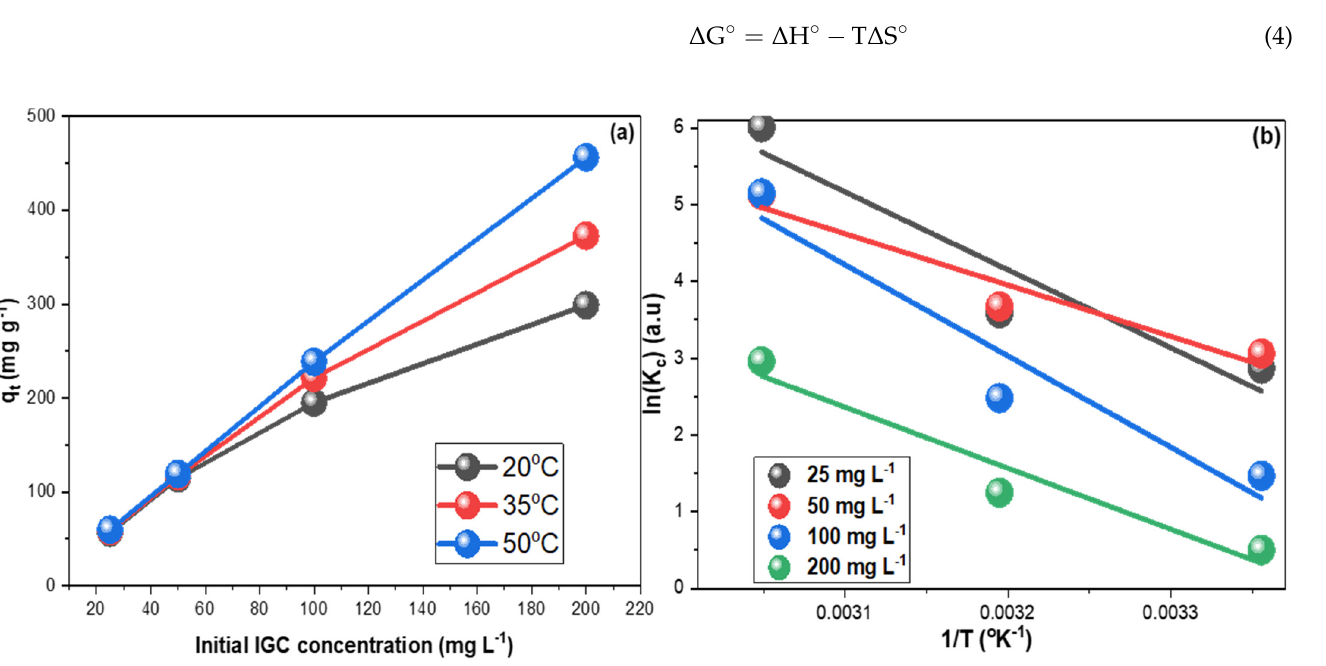
Figure 10. ( a ) The effect of IGC initial fed concentration on its sorption by the Al 2 O 3 -NiO nanocomposite at 20, 35, and 50 °C; ( b ) the thermodynamic investigation of IGC sorption by Al 2 O 3 - NiO nanocomposite from 25, 50, 100, and 200 mg L − 1 solutions at 20, 35, and 50